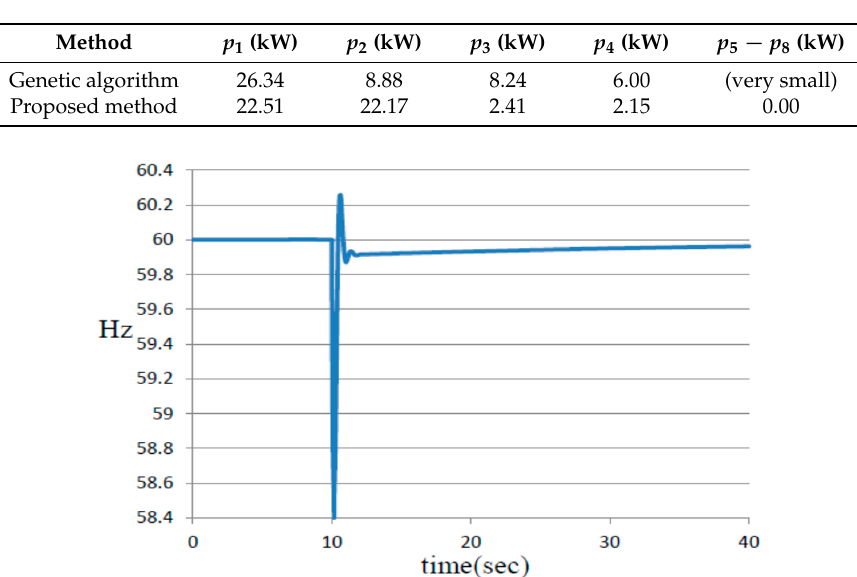
Table 5. Results obtained using genetic algorithm and the proposed method.